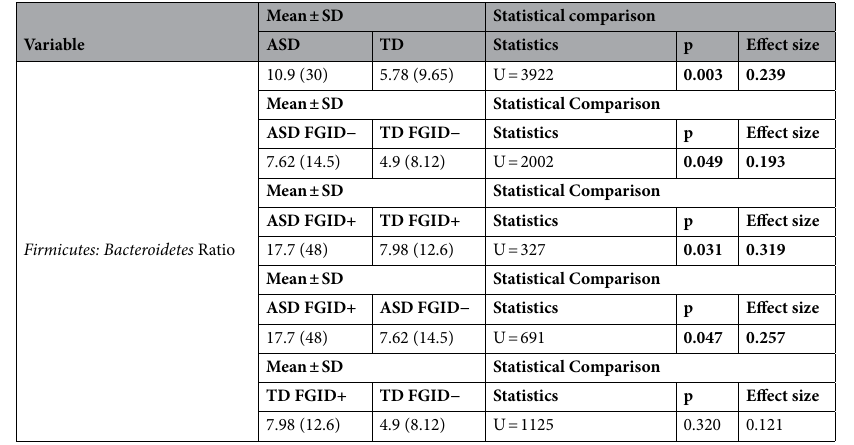
Table 4. Summary of Mann–Whitney U tests on the Firmicutes: Bacteroidetes ratio across ASD and TD groups. Significant values are in bold. ASD Autism Spectrum Disorder, TD Typically Developing, FGID Functional Gastrointestinal Disorder. Effect sizes were calculated with rank biserial correlation.